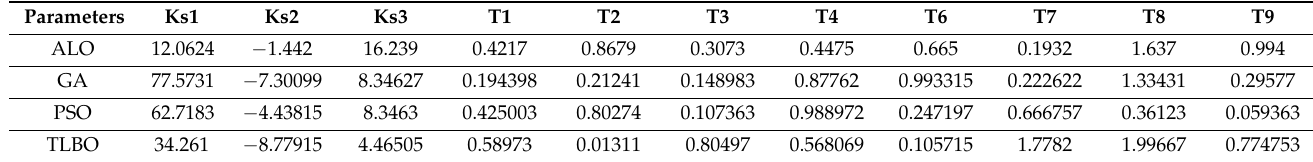
Table 6. Optimal parameter values of the dual-input power system stabilizer.